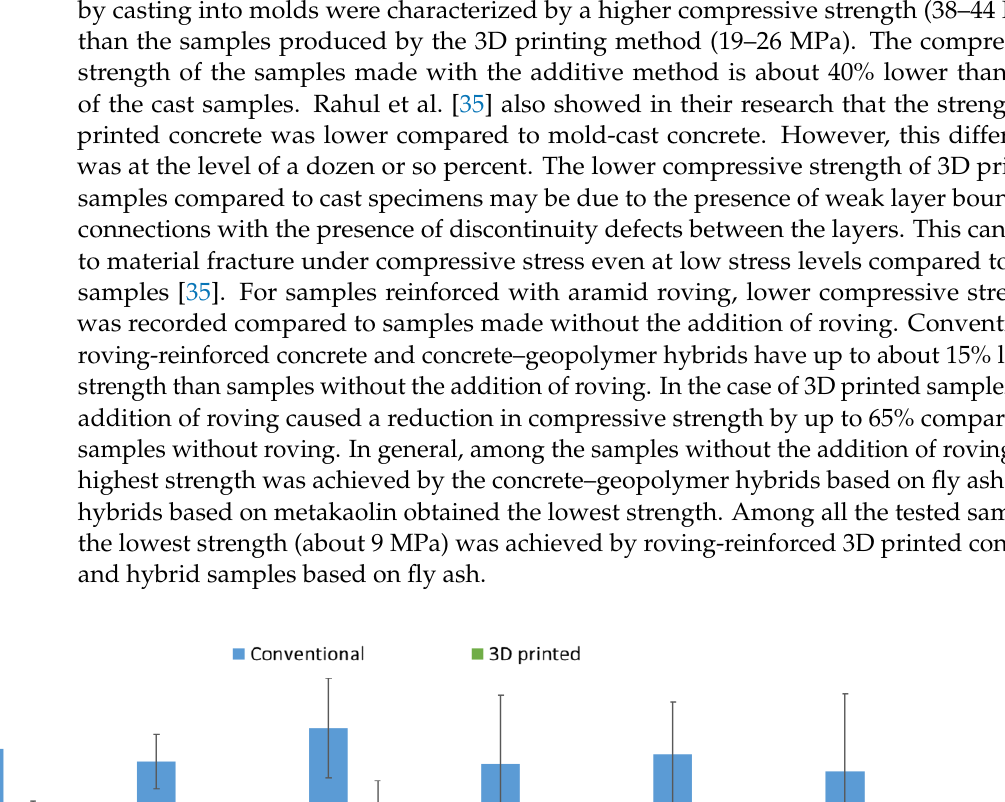
Figure 5. Residual compressive strength after the freeze – thaw cycles of concrete and concrete – geo- polymer hybrids produced by casting and 3D printing.